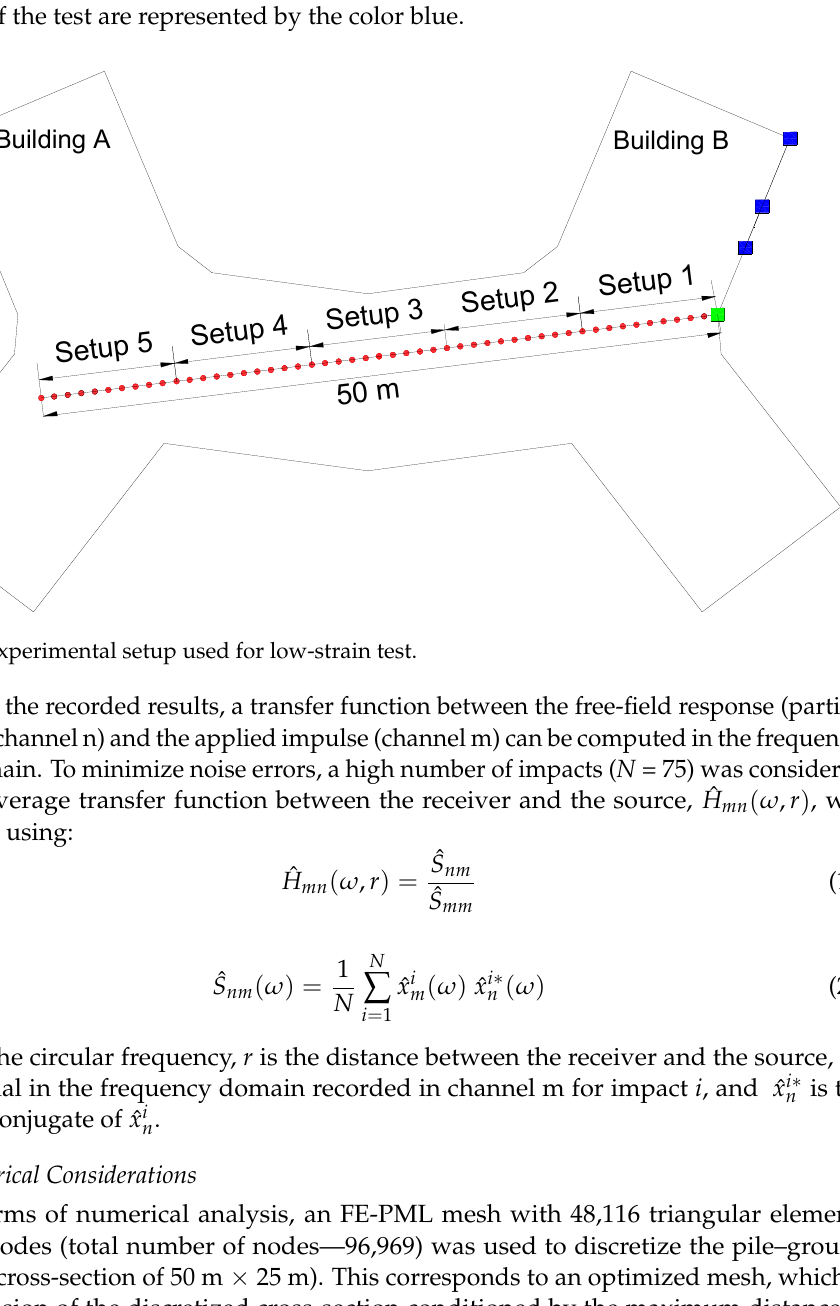
Figure 8. Example of the impact hammer force: ( a ) time history; ( b ) frequency content.